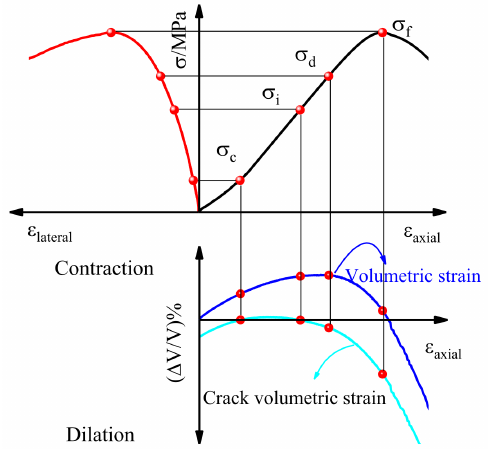
Figure 8. Schematic diagram of phase division and characteristic